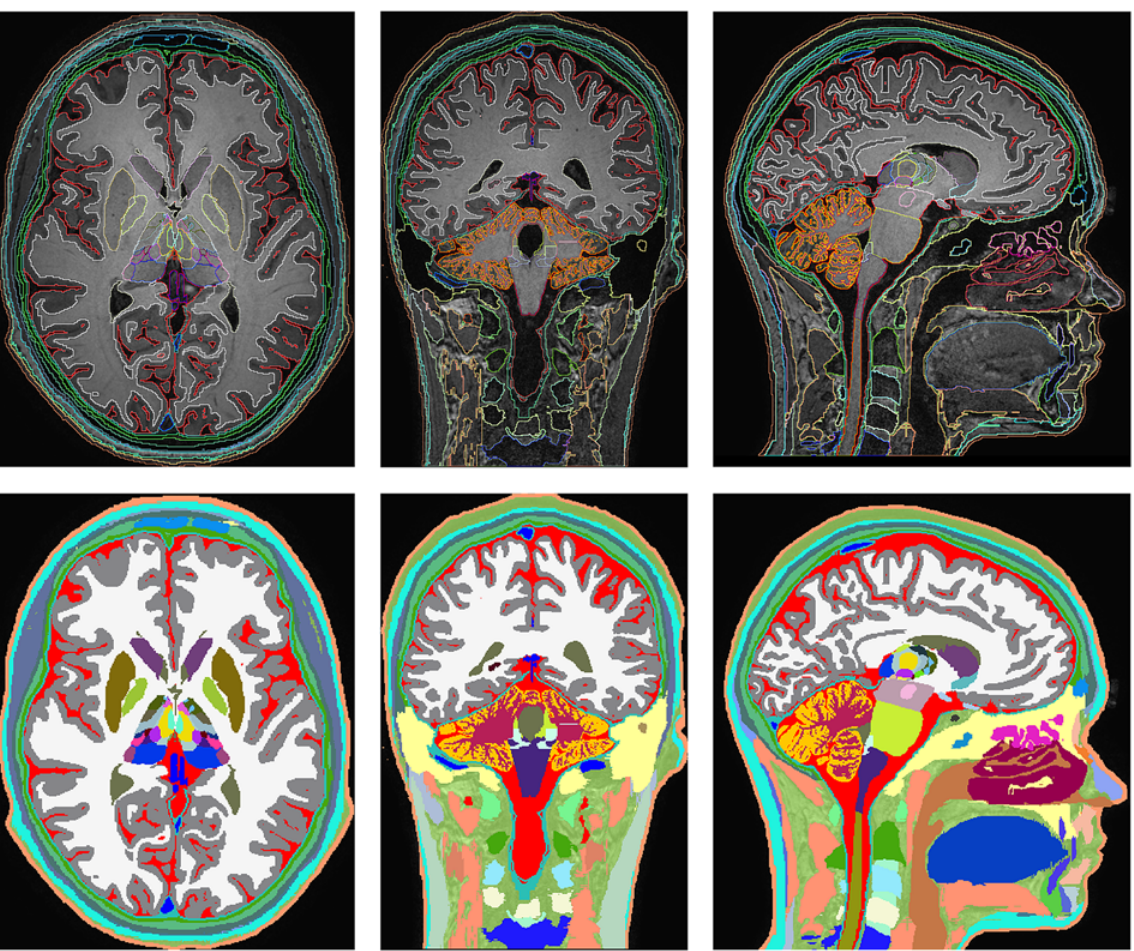
Fig 5. Final segmentation. Axial, coronal, and sagittal views of the outlines of the segmented head and neck structures (top row) and the color-coded label maps (bottom row).